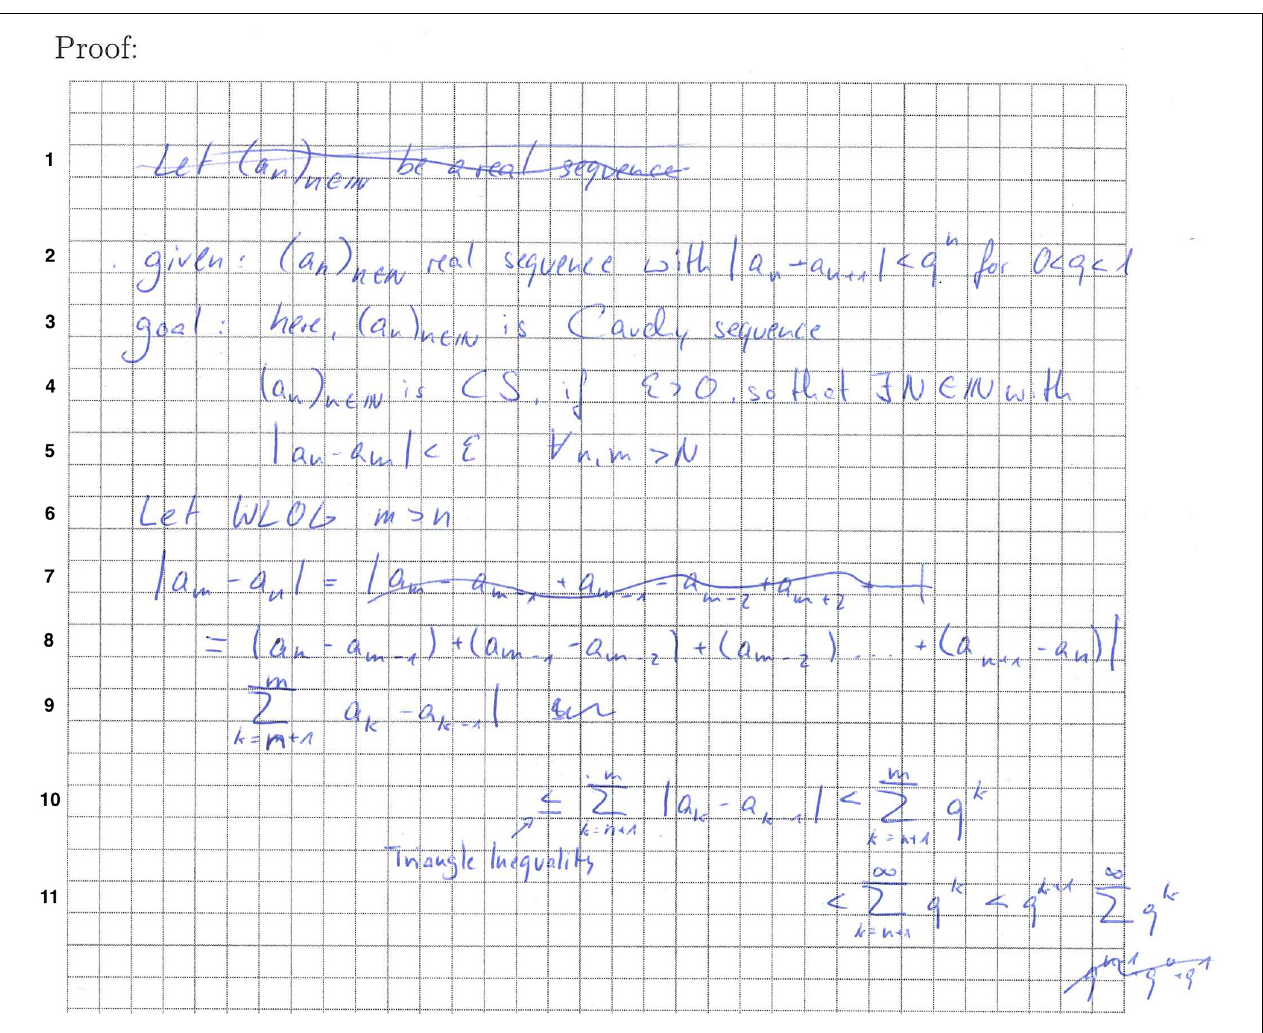
FIGURE 8 | Leia’s proof attempt (translated; line numbers